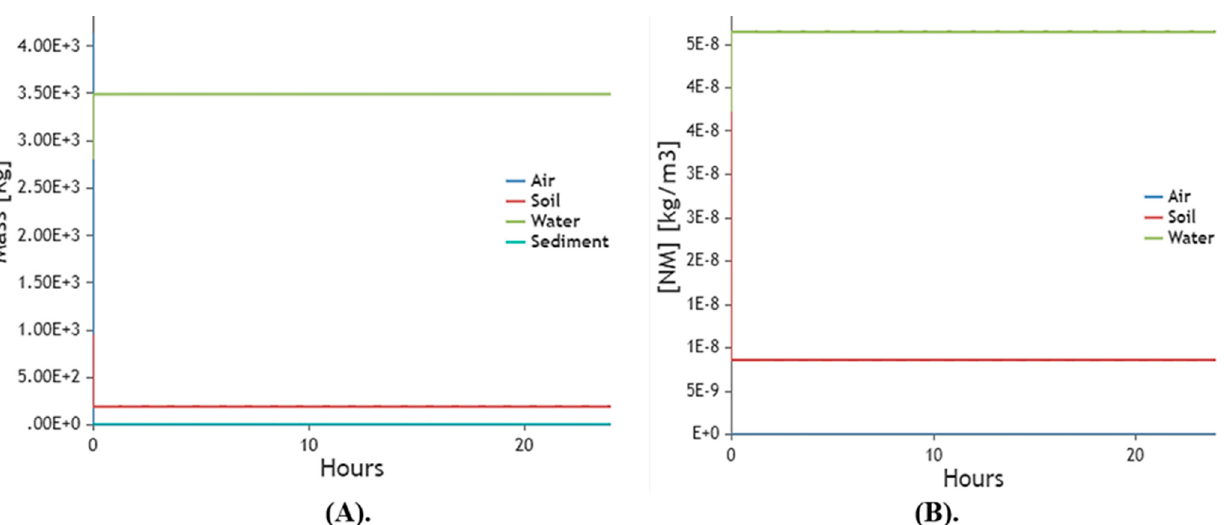
Figure 14. Exposure model based on working parameters showing ( A ). Mass production of ZVI-NPs (at large scale) ( B ). Particle production of ZVI-NPs (at small scale) at a particular time.